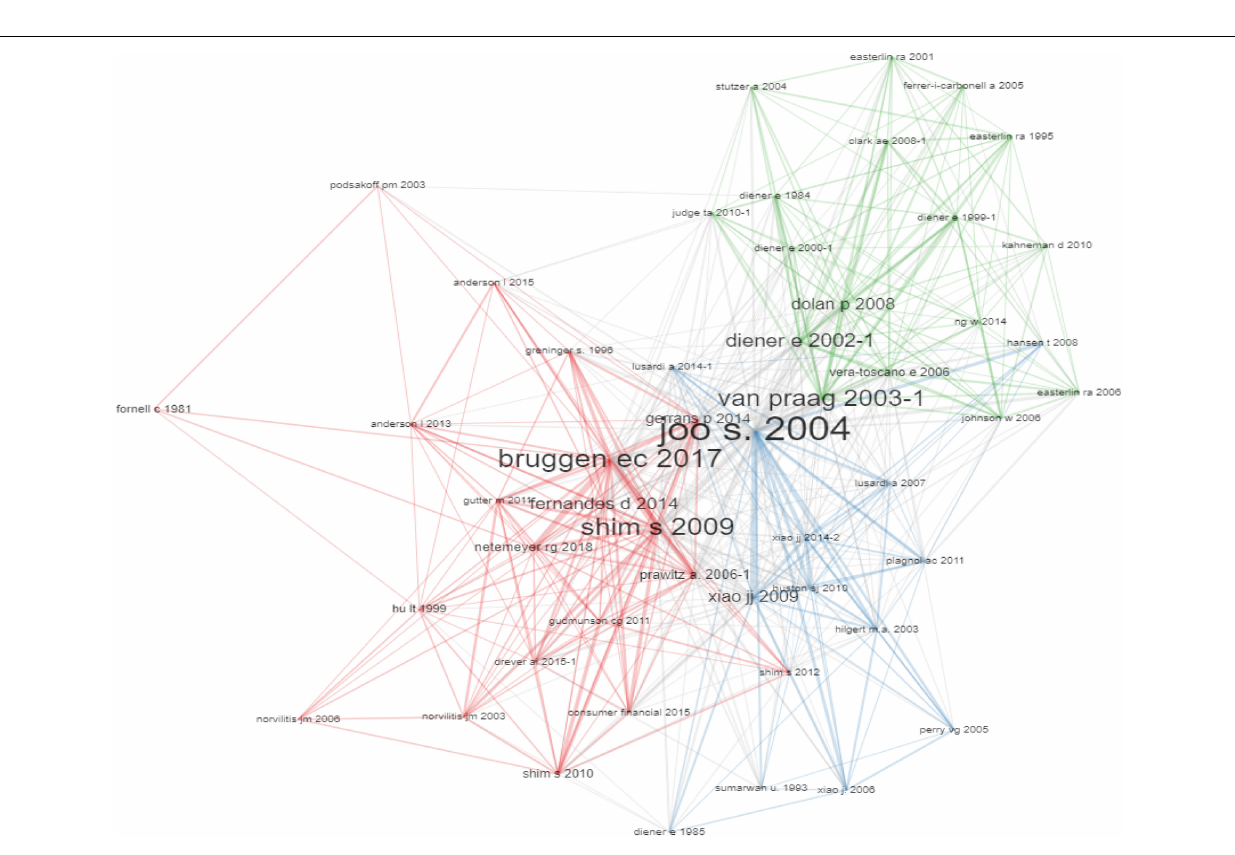
FIGURE 5 | Co-citation